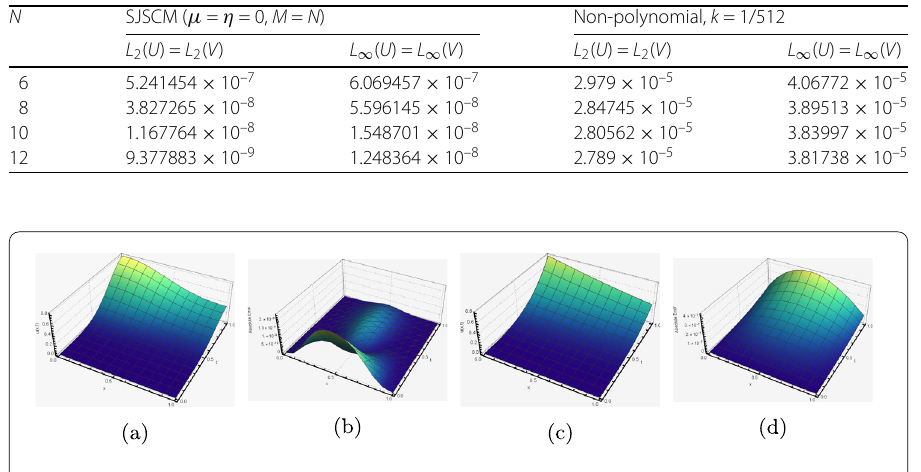
Figure 1 ( a ) and ( b ) represent approximate solution and absolute error distribution, respectively, using SJSCM. ( c ) and ( d ) represent approximate solution and absolute error distribution, respectively, using the non-polynomial B-spline method of Example 1 at α 1 = α 2 = 0.1, N = 12, 0 ≤ x ≤ 1